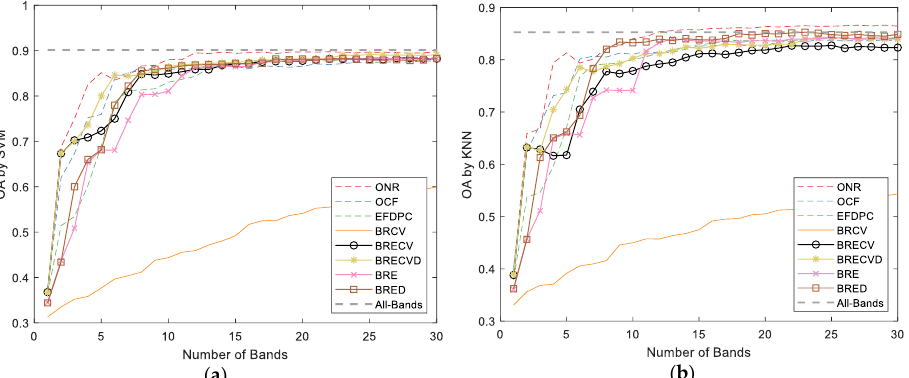
Figure 4. OA curves produced by SVM and KNN classifiers for the Pavia University data set. ( a ) The OA curves produced by SVM classifier. ( b ) The OA curves produced by KNN classifier.